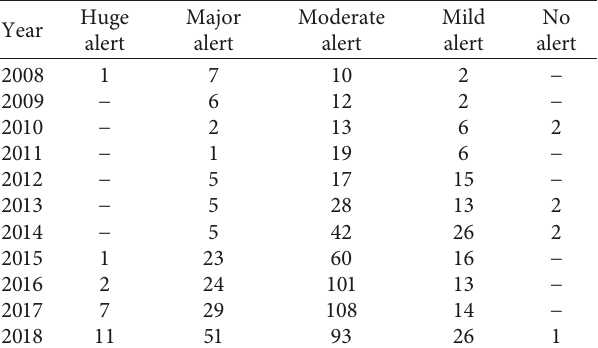
Table 8: Financial risk classification of 182 listed companies from 2008 to